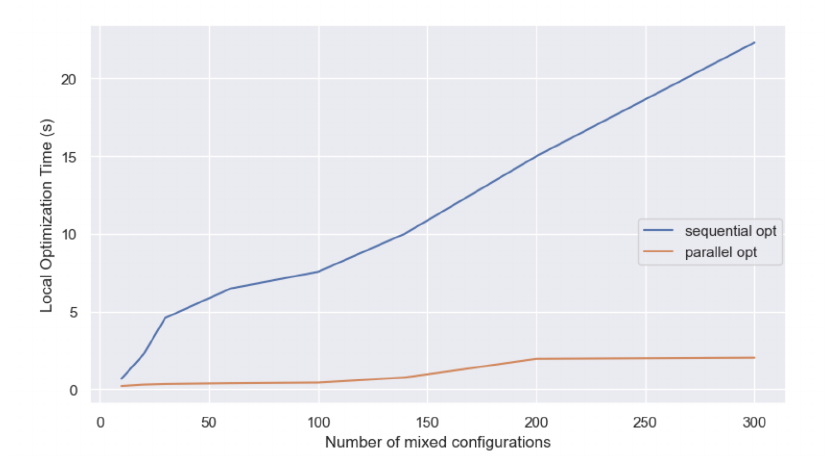
Figure 21. Sequential/parallel Local